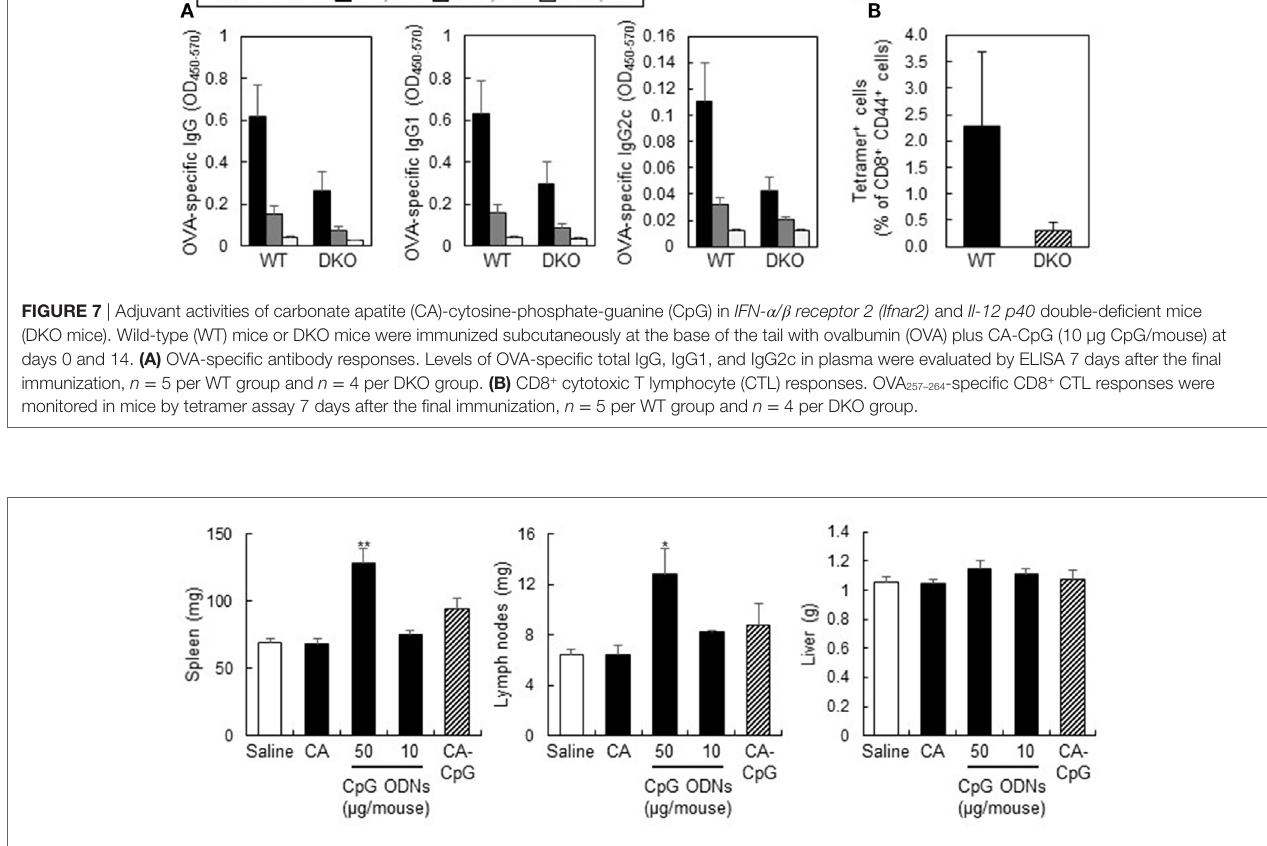
FigUre 8 | Strong adjuvant effects of carbonate apatite (CA)-cytosine-phosphate-guanine (CpG) without splenomegaly. Mice were treated with CA-CpG (10 µg CpG oligodeoxynucleotides (ODNs)/mouse), CA nanoparticles or K-type CpG ODNs (10 or 50 µg CpG ODNs/mouse) subcutaneously at the base of the tail at days 0, 2, and 4. Twenty-four hours after the final administration, the spleen, liver, and lymph nodes were weighed. CA-CpG did not induce splenomegaly; in contrast, a high dose of K-type CpG ODNs did induce splenomegaly, n = 5 per group. Data are given as mean ± SEM. * p < 0.05, ** p < 0.01 vs. saline-treated group as indicated by Tukey’s test.